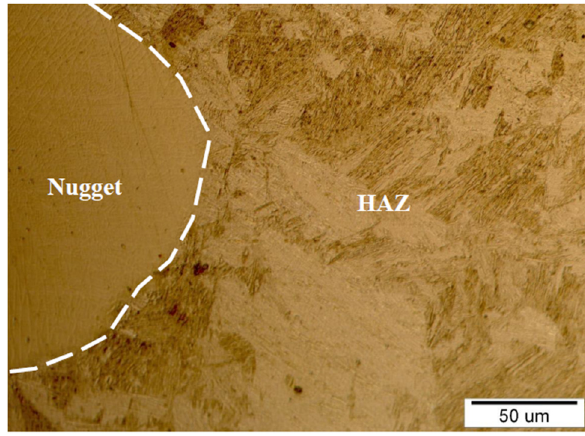
Figure 19: Optical micrograph of the interface of nugget zone and